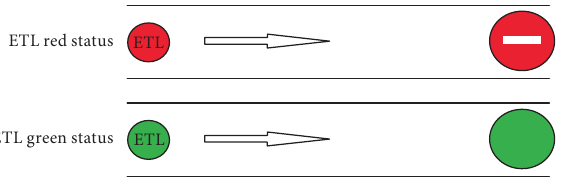
Figure 4: The ETL traffic light which is a dual mode traffic light that is set at the entrance of a link to show the exit status of the link is shown. The entrance to a link is allowed in both cases of red and green ETL, but the exit is banned in the case of red ETL.